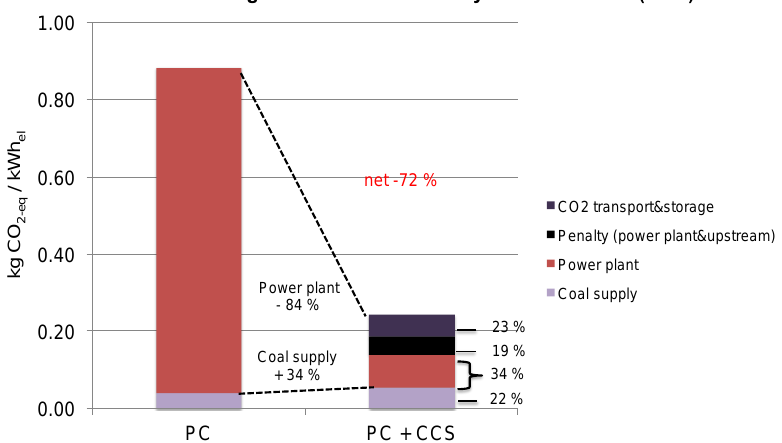
Figure 8. Contribution of individual life cycle phases to the global warming potential for supercritical PC with and without CCS in South Africa in 2030.